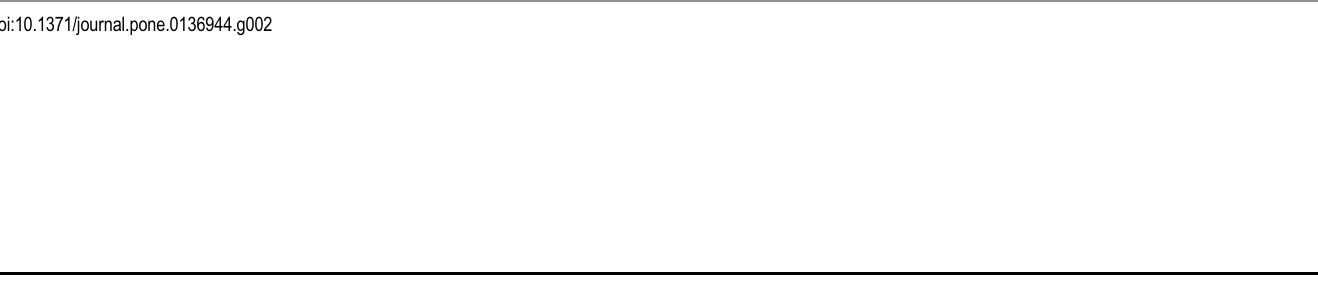
Fig 2. Bland-Altman plots for the agreement of physical activity measurement (min/day) between the GPAQ and accelerometer. Comparisons of total-minute of activity versus a 10-minute bout definition at each of three intensities: MVPA, vigorous-, and moderate- intensity activities for the total sample (n =